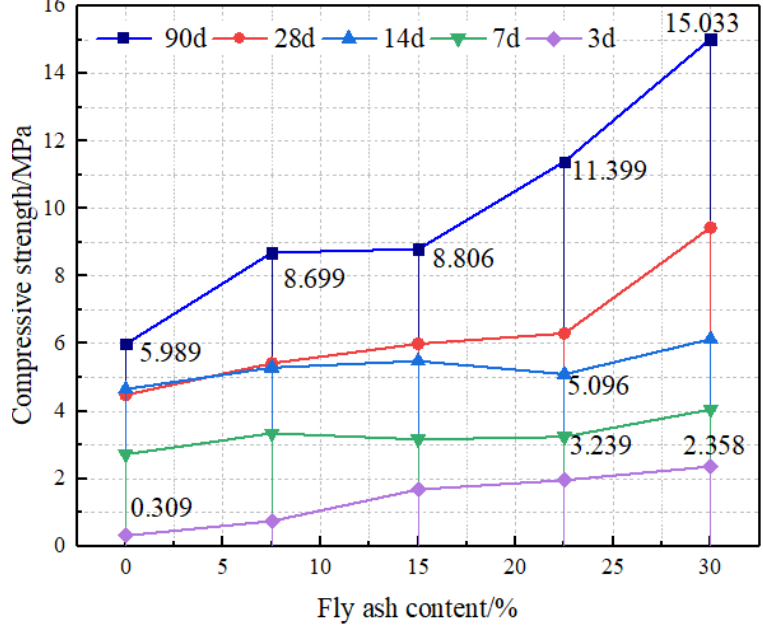
Figure 9. Effect of fly ash content on strength of backfill. Figure 9. E ff ect of fly ash content on strength of